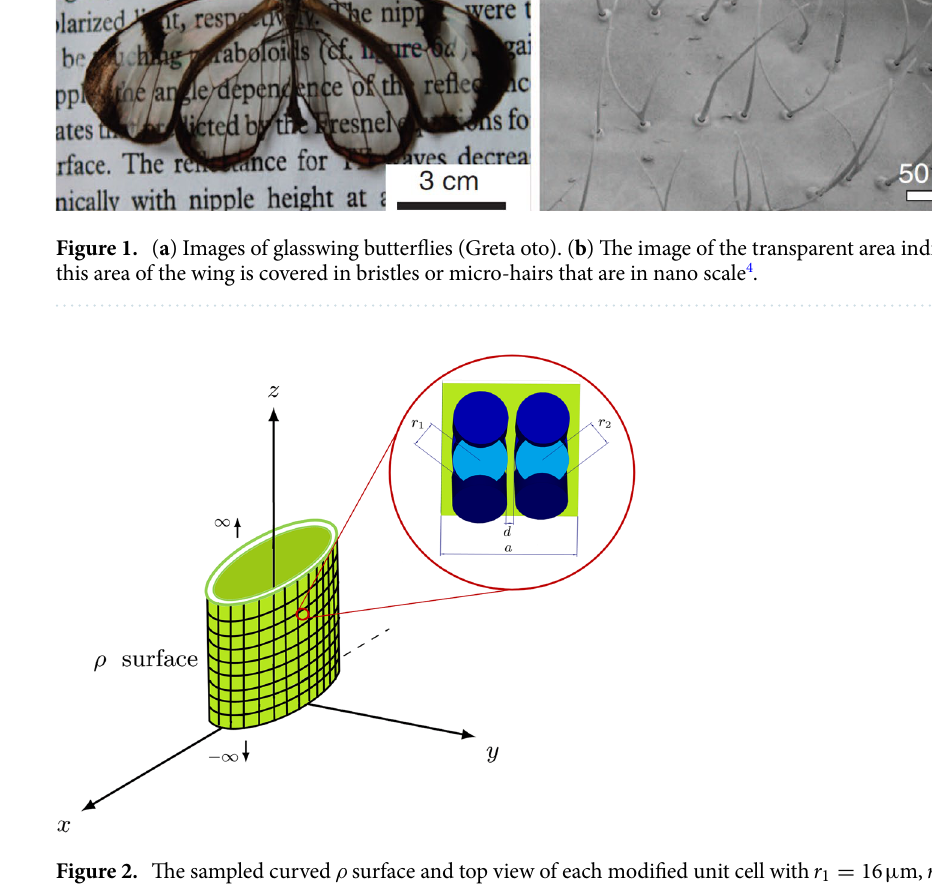
Figure 2. The sampled curved ρ surface and top view of each modified unit cell with r 1 = 16 µ m, r 2 = 15.5 µ m, d = 3.38 µ m and a = 80 µ